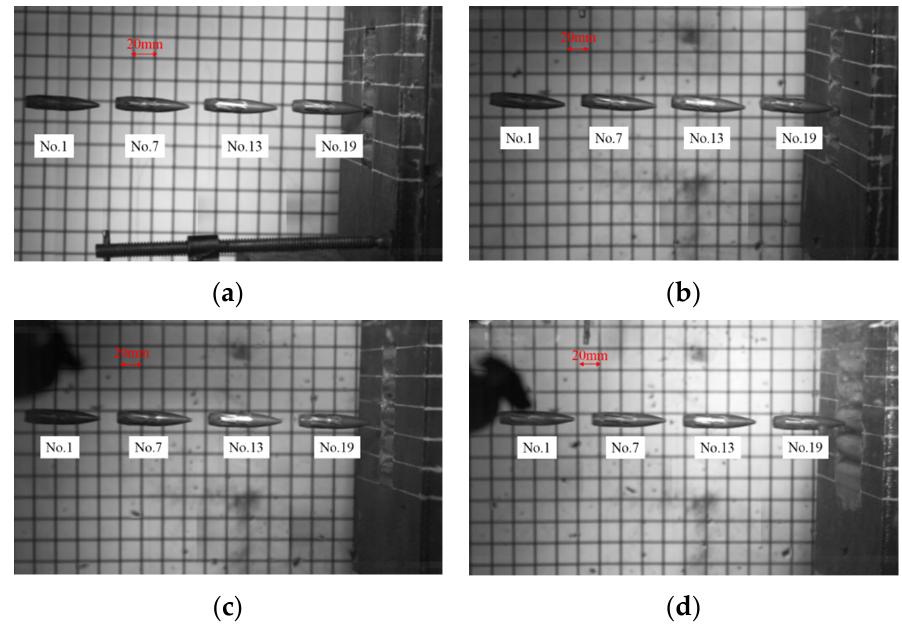
Figure 3. High-speed photographs of impact points, ( a ) Experiment 1, ( b ) Experiment 2, ( c ) Experi- ment 3, ( d ) Experiment 4.